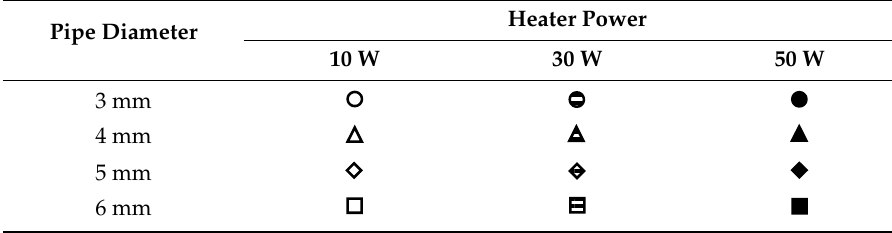
Table 4. Symbols for pipe diameters and heater powers.